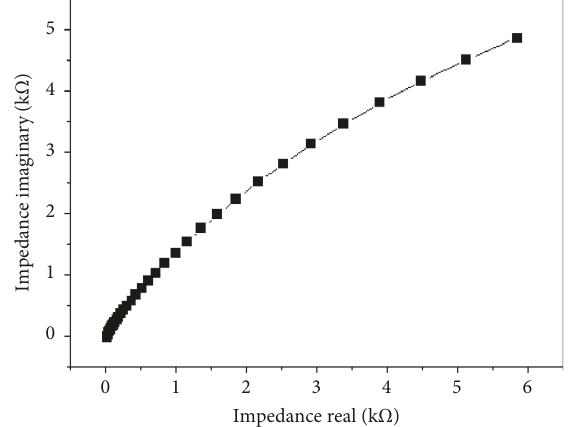
Figure 4: Impedance spectrum indicating resistive behavior of HAC-EDTA at higher than